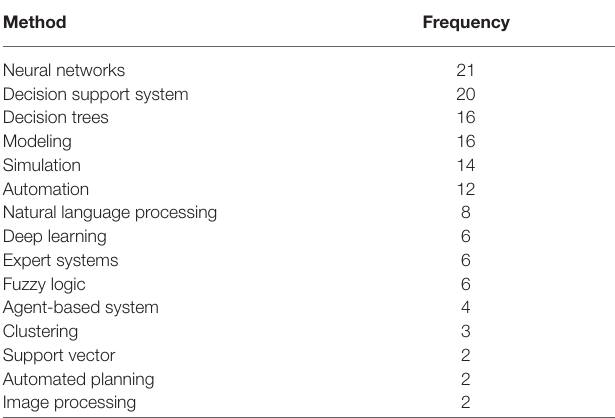
TABLE 3 | Frequency of AI